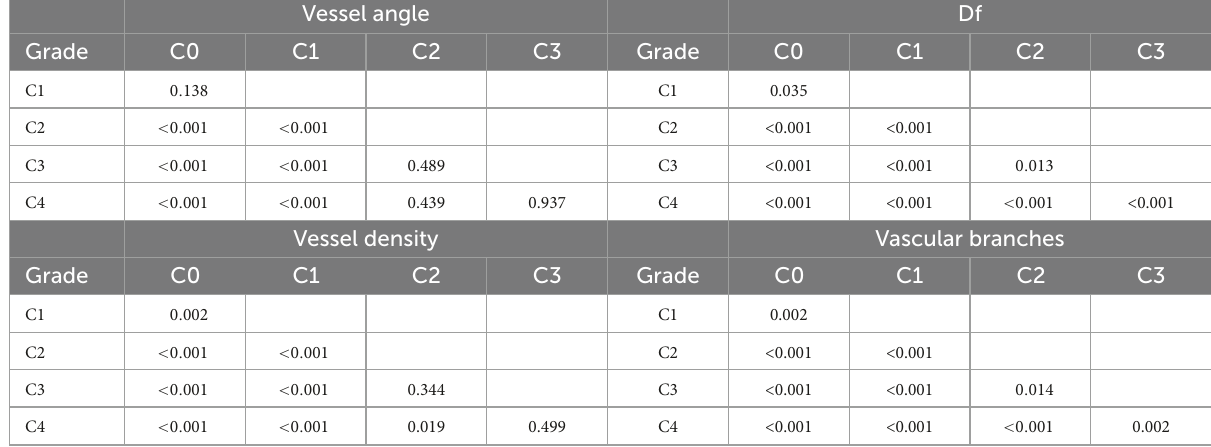
BCVA,bestcorrectedvisualacuitypresentedasthelog(minimumangleofresolution);AL,axiallength;Df,fractaldimension. TABLE 2 Pairwise comparisons of morphological characteristics among HM